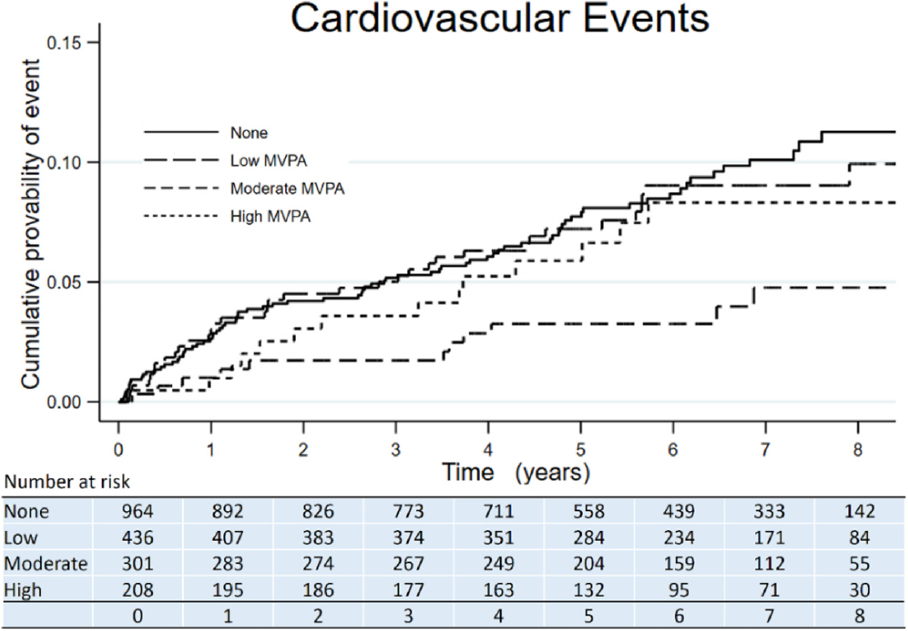
Figure 2. Kaplan–Meier survival curve of CVE across categories of MVPA amount in adults with nondialysis CKD.